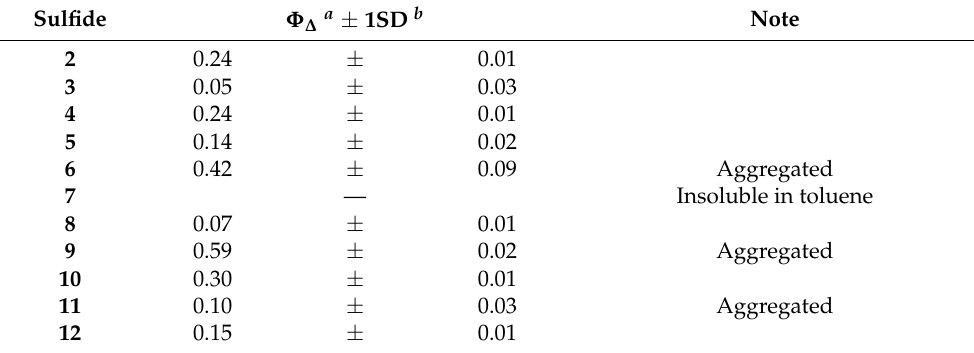
Figure 4. Sulfide compounds 3 – 12 used for ligand exchange reactions. Table 1. Change in singlet oxygen quantum yield ( Φ ∆ ) upon ligand exchange reactions with sulfide compounds 2 – 12